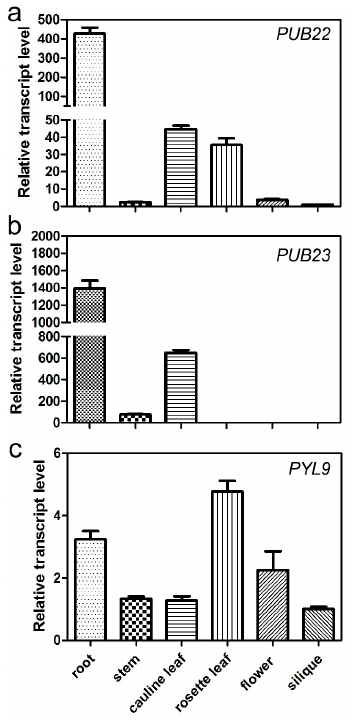
Figure 6. Expression patterns of PUB22 , PUB23 and PYL9 . ( a – c ) Quantitative real-time PCR was used to determine the expression of PUB22 ( a ); PUB23 ( b ); and PYL9 ( c ), in root, stem, cauline leaf, rosette leaf, flower, and silique of the Arabidopsis wild-type Col-0. Data are the means ± standard errors ( n = 4).